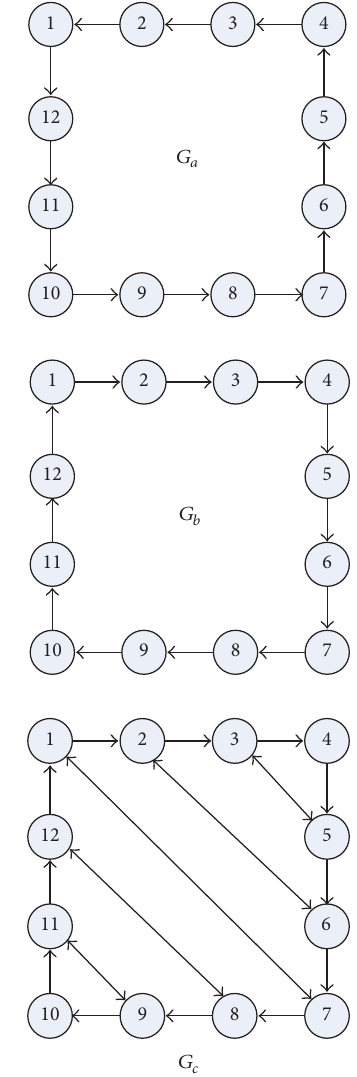
Figure 1: Strongly connected and balanced graphs.